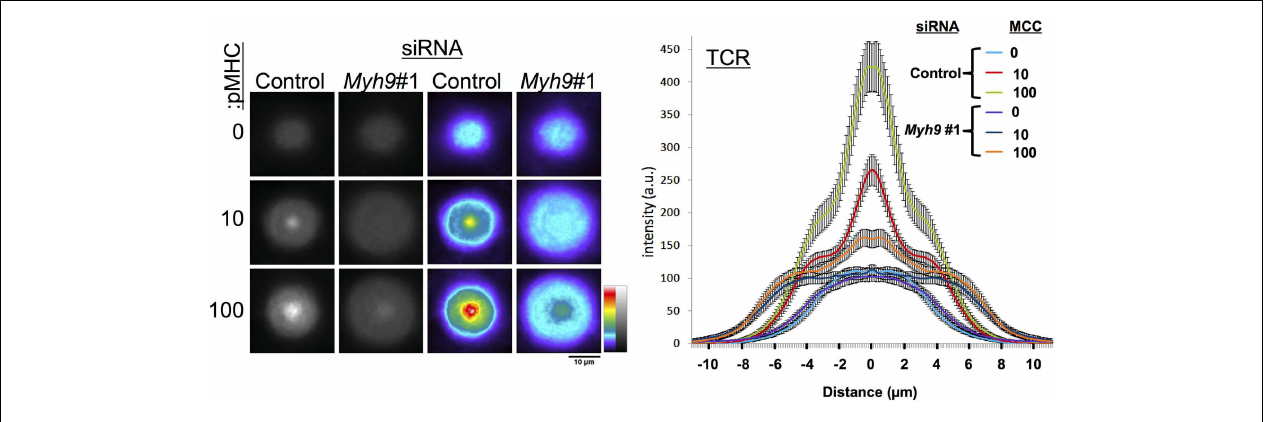
their centroids on bilayers of different protein concentrations.The graph on the right shows diameter profile plots of protein distributions with SEM across the cells from periphery to center back out through